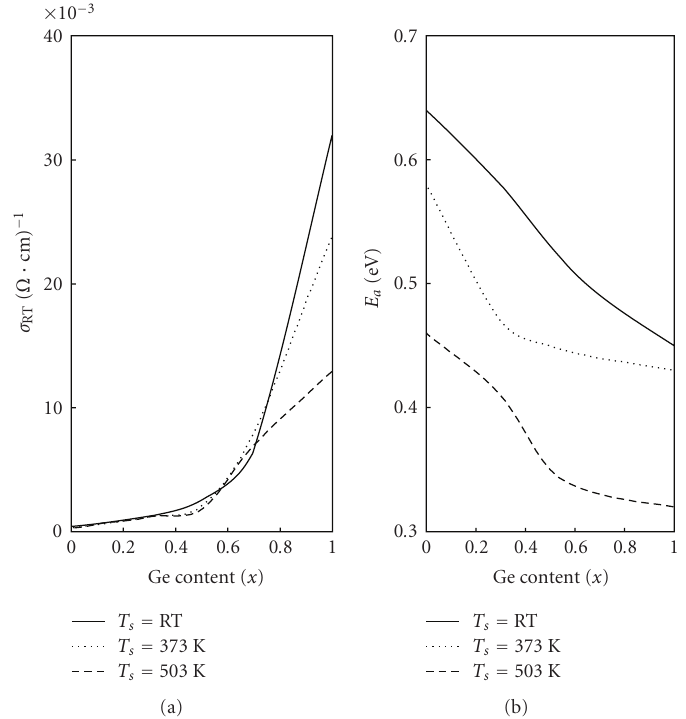
Figure 2: Variation of (a) σ R · T and (b) E a as function of Ge content ( x ) for a-Ge x Si 1 − x :H thin films at di ff erent substrate